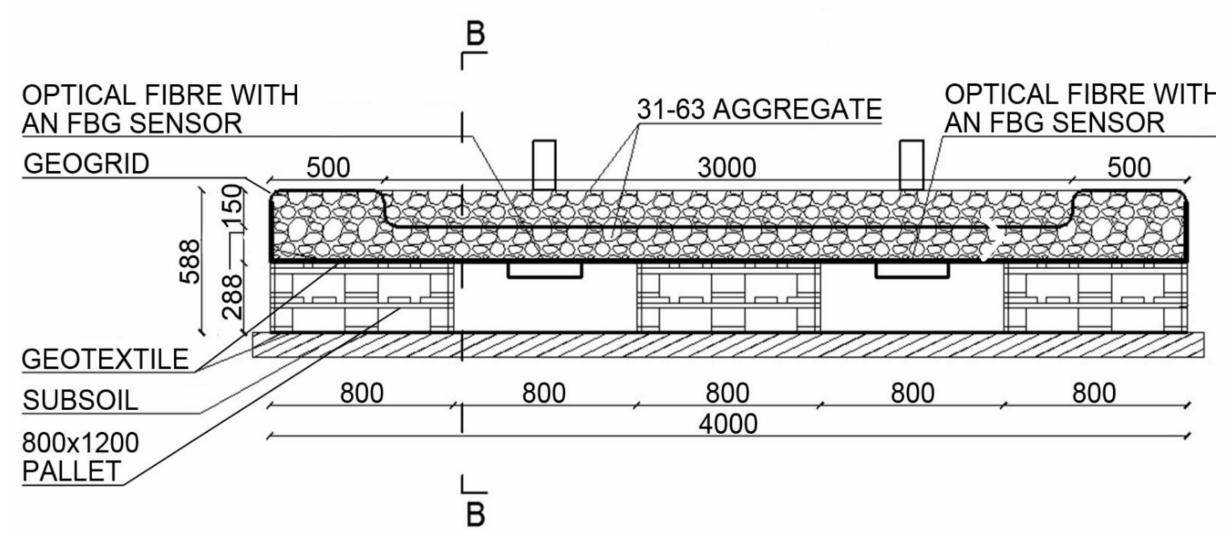
Figure 5. Diagram of test stand 2 (cm) .